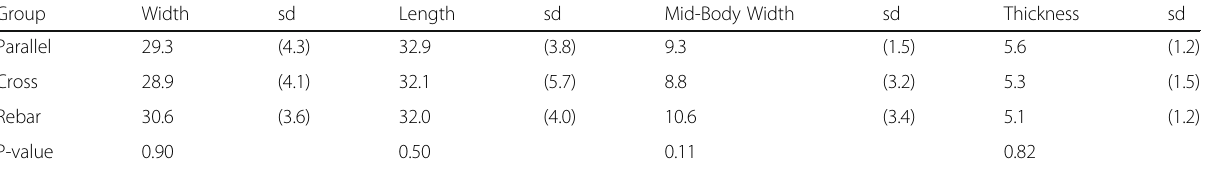
Table 2 Lateral Meniscus dimensions (mm) of 3 groups: parallel stitches, Cross Stitch and Rebar Repair Group Width sd